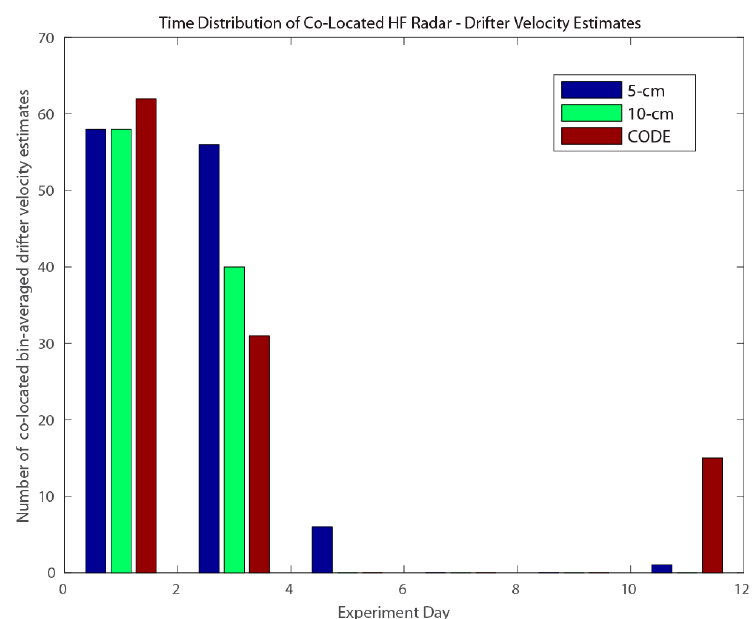
Figure 4. Histogram (bin size of two days) of the number of co-located bin-averaged drifter velocity data points (with at least fifteen 5-min velocity measurements) and HF radar velocity measurements. Blue = 5-cm drifters, Green = 10-cm drifters, and Blue = CODE-style drifters.